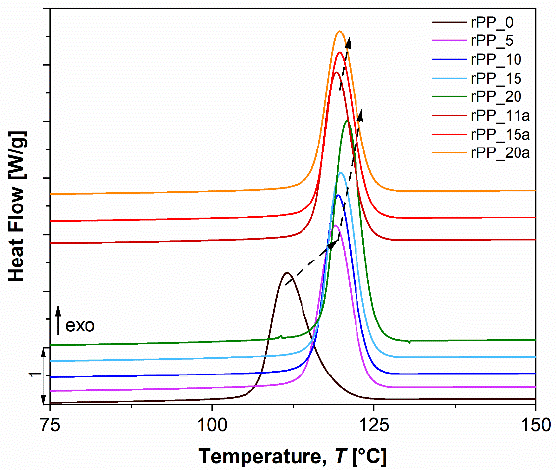
Figure 4. DSC thermograms of crystallization peaks of virgin PP, and recycled PP without and with additive.